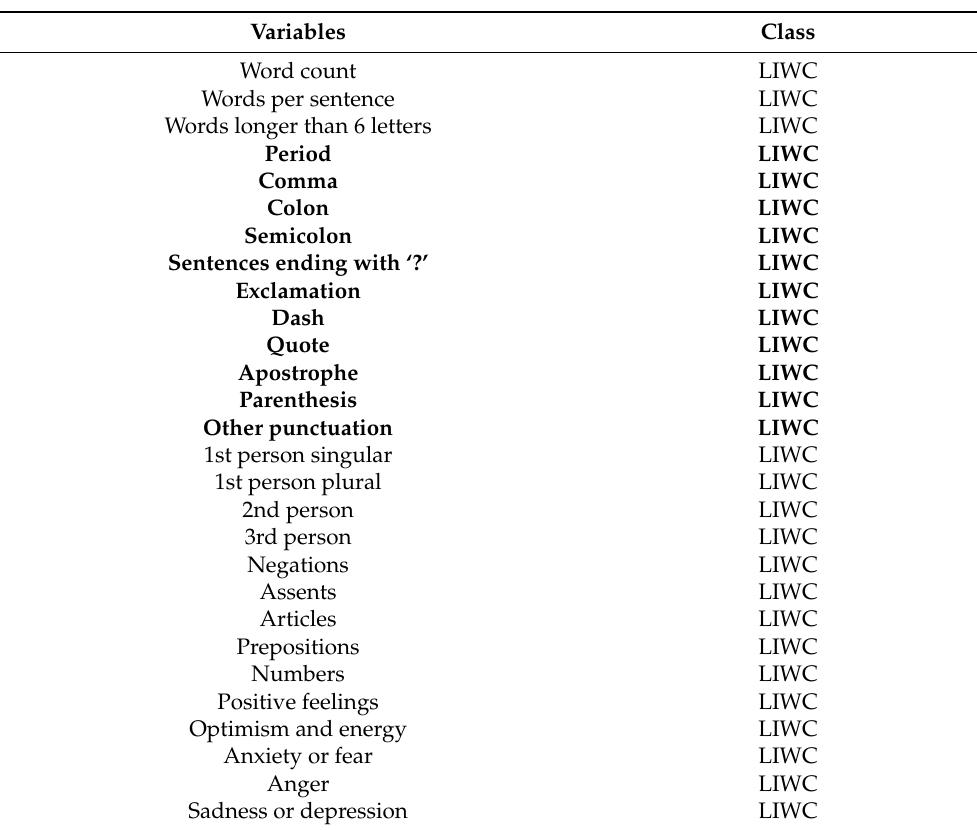
Table A2. Variables in the